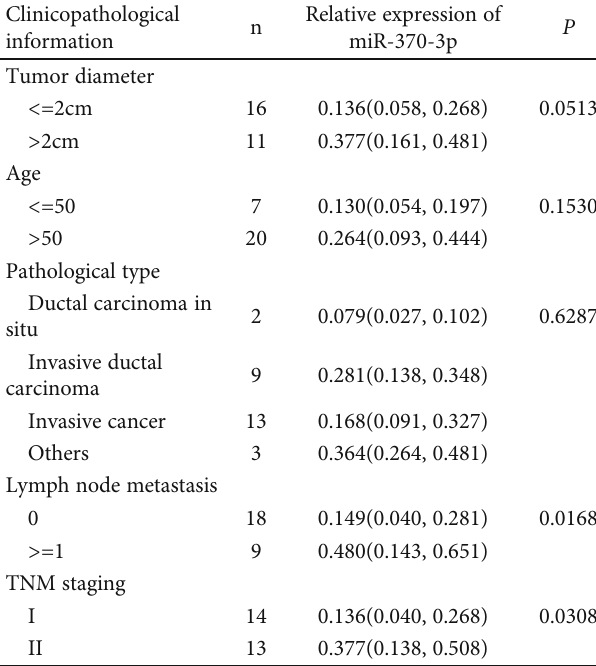
Table 3: Correlation between miR-370-3p in breast cancer serum and clinicopathological parameters.